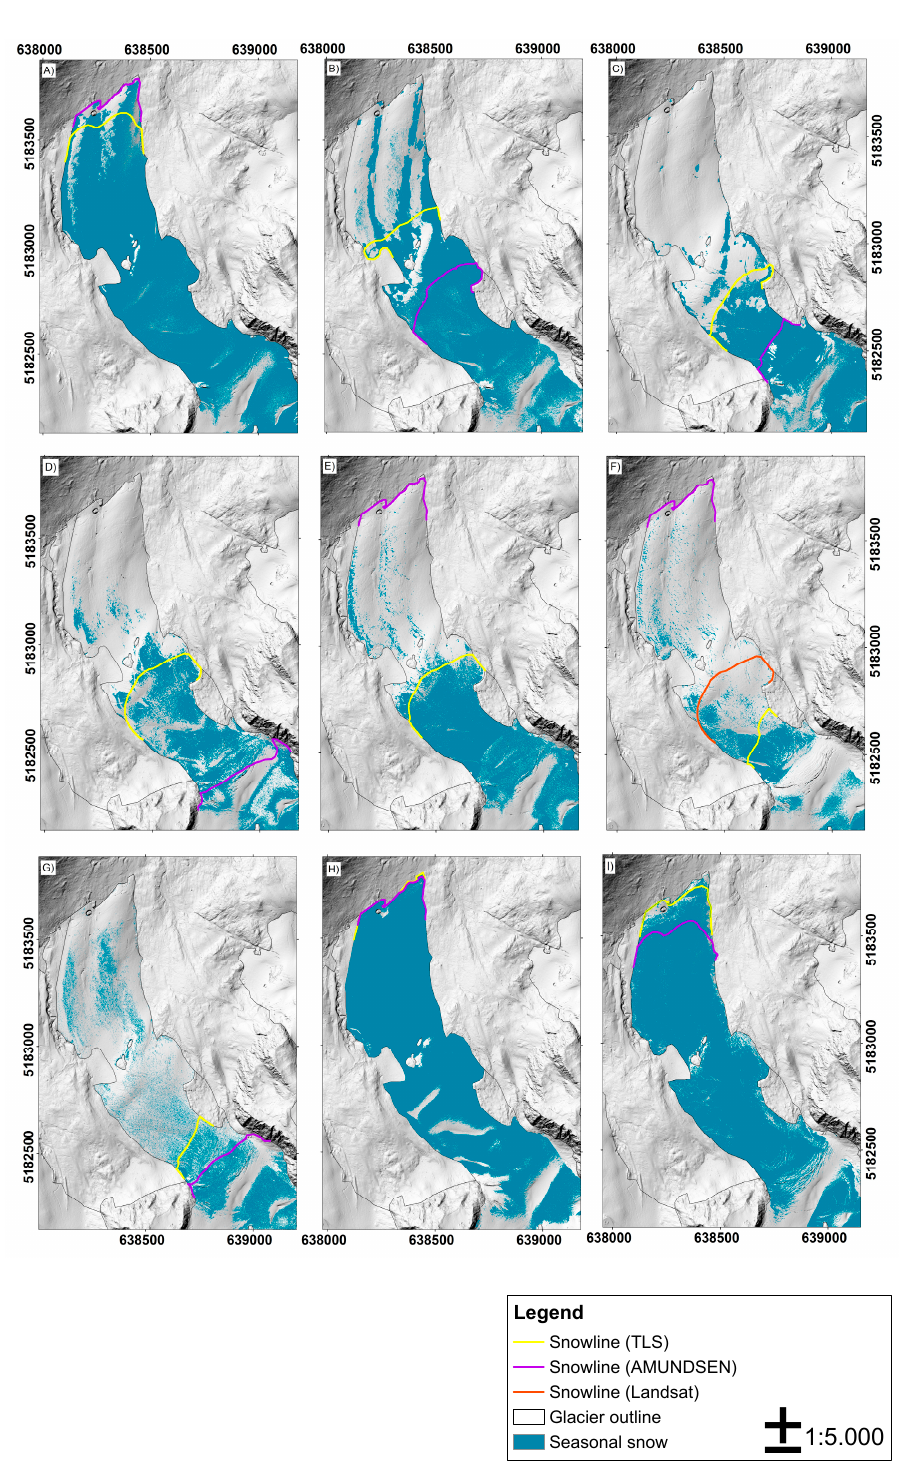
Figure 5. Evolution of the TLS and AMUNDSEN snowlines during summer 2014 and summer 2015. The order of the raster layer is: ( A ) 26 June 2014, ( B ) 18 July 2014, ( C ) 1 August 2014, ( D ) 25 August 2014, ( E ) 4 September 2014, ( F ) 23 September 2014, ( G ) 4 October 2014, ( H ) 21 April 2015 and ( I ) 1 October